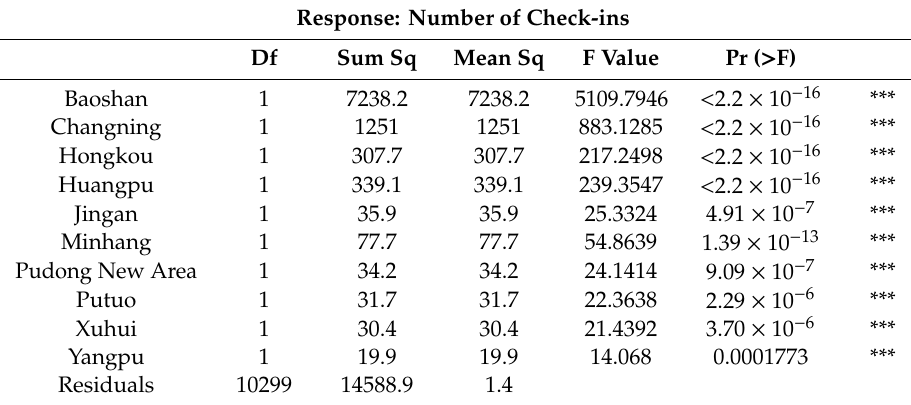
Table 5. Analysis of variance